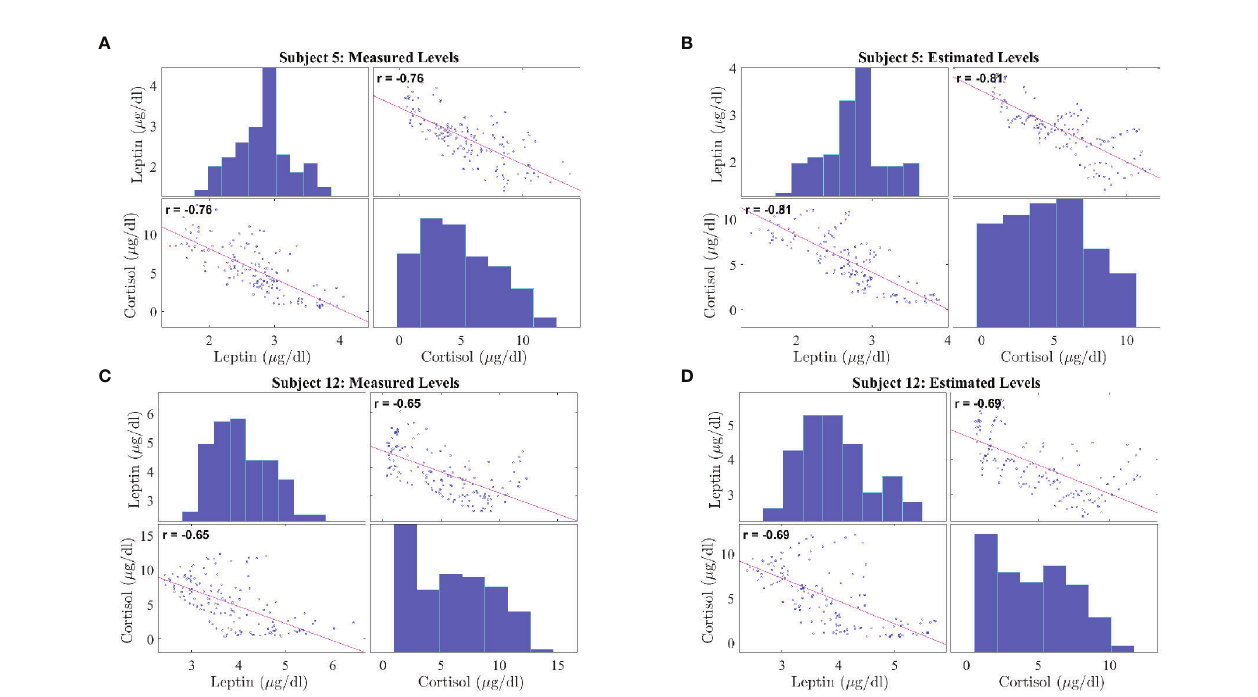
FIGURE 5 | Correlation Plot between Leptin and Cortisol Levels in Patients with Obesity. The correlation plots are as follows: (A) measured leptin and cortisol levels for subject 5, (B) estimated leptin and cortisol levels for subject 5, (C) measured leptin and cortisol levels for subject 12, (D) estimated leptin and cortisol levels for subject 5. Each correlation plot incorporates a histogram and a scatter plot: the top left plot shows a histogram depicting leptin distributions and the bottom right plot shows a histogram depicting cortisol distributions, the bottom left plot and top right plot shows the scatter plot depicting correlation between leptin and